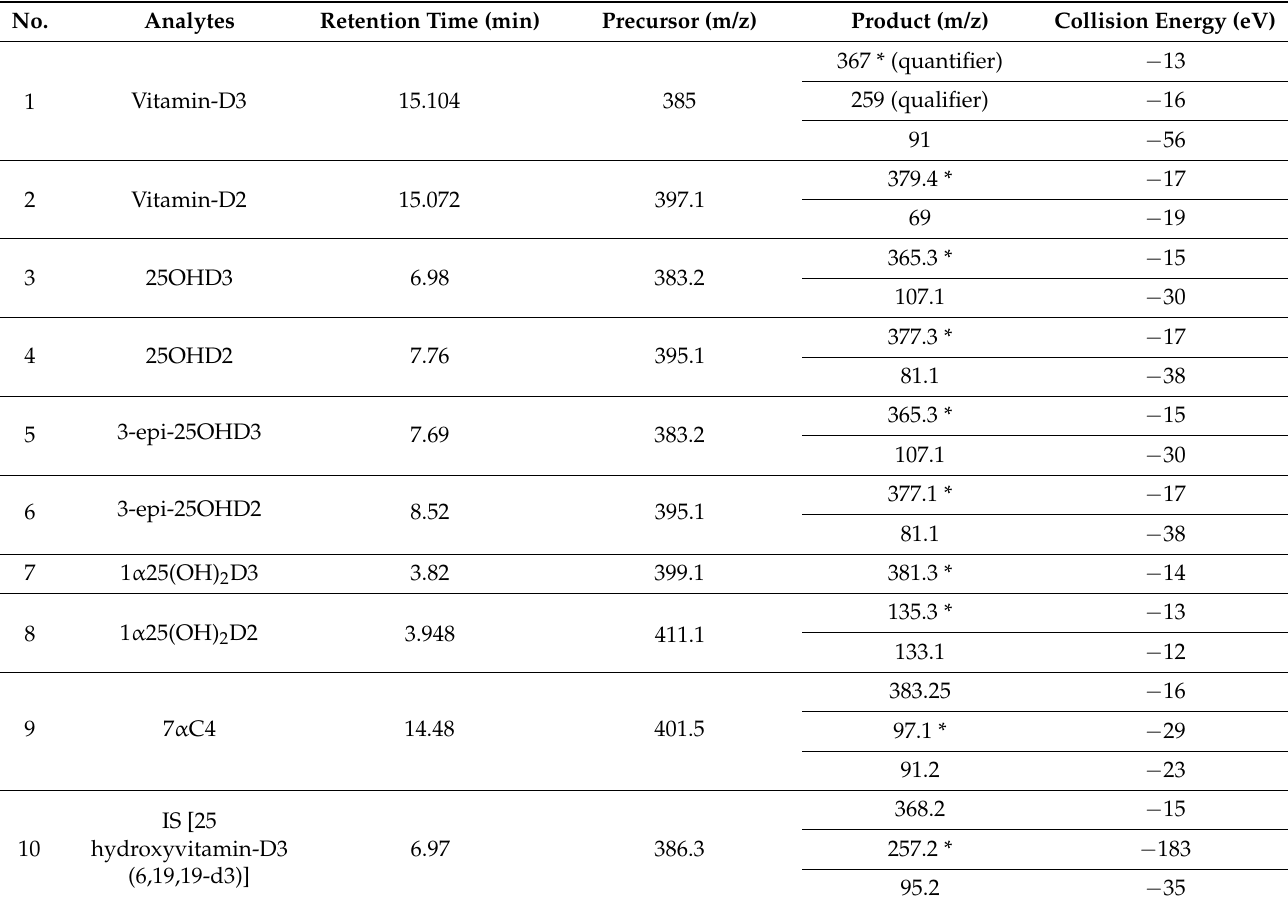
Table 3. Vitamin D and its metabolites are shown along with respective precursor/product ions, retention times, and collision energy. Transitions marked with asterisks (*) were used for